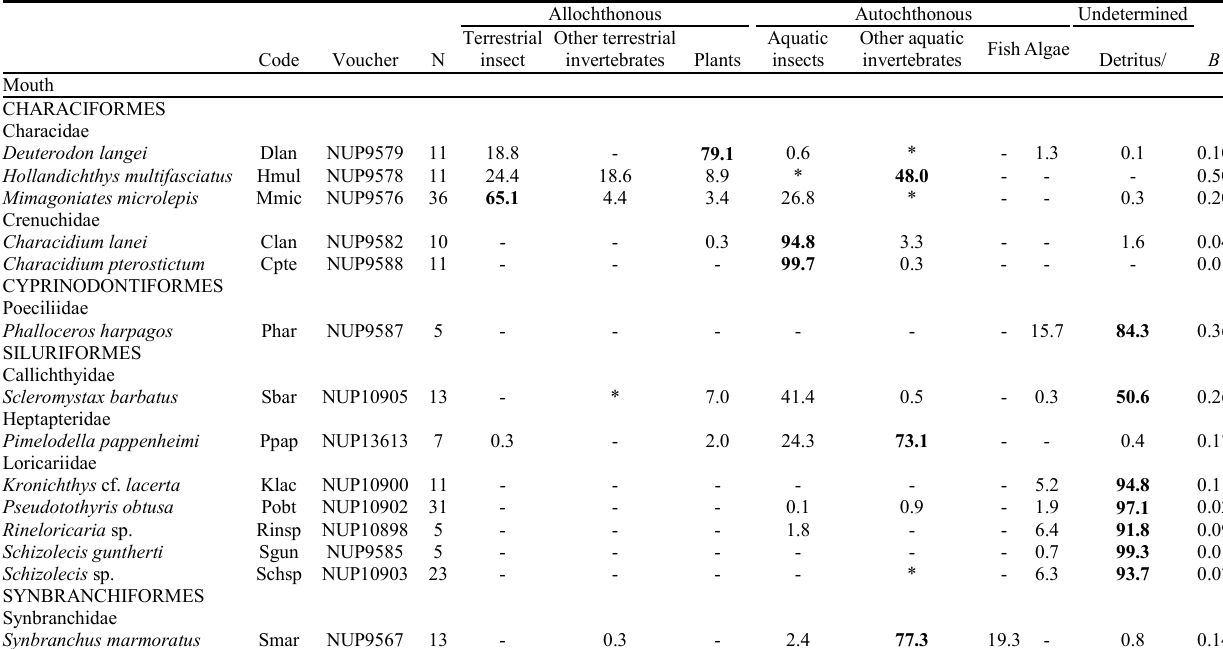
Table 3. cont. Systematic position, diet composition and breadth (Levin’s index B ) of fish assemblage of the Vermelho River, East Atlantic basin, southern Brazil. Data are expressed as percentage volume of food items. Number of stomachs analyzed (N); * = Values < 0.1%; – not recorded. Predominant items are in bold.